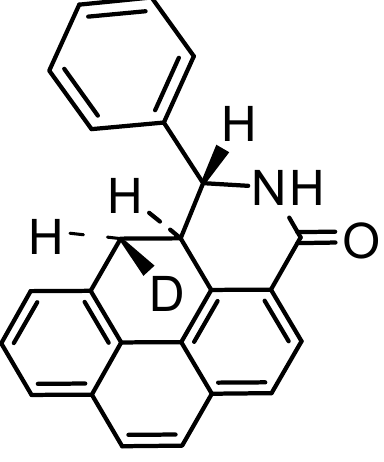
Figure 3. The molecular structure of 6 ‐ d .